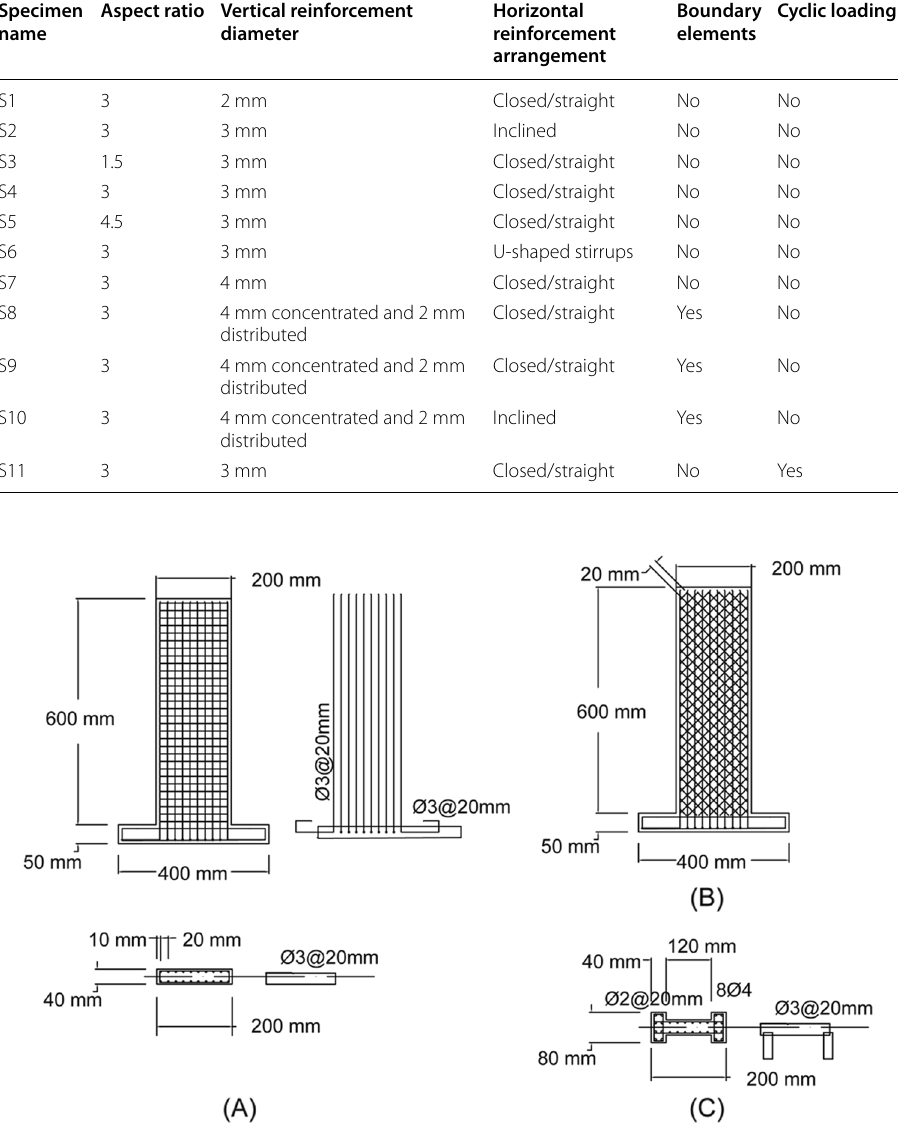
Fig. 1 A Typical reinforcement detailing for scaled shear wall, B reinforcement detailing for inclined stirrups, and C cross-section of shear wall with end enlargement and steel